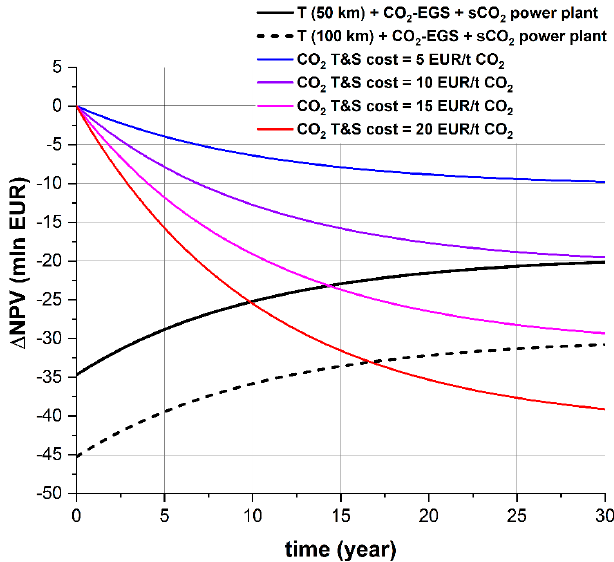
Figure 15. Δ NPV resulting from different options for capture CO 2 utilization and storage. Figure 15. ∆ NPV resulting from di ff erent options for capture CO 2 utilization and